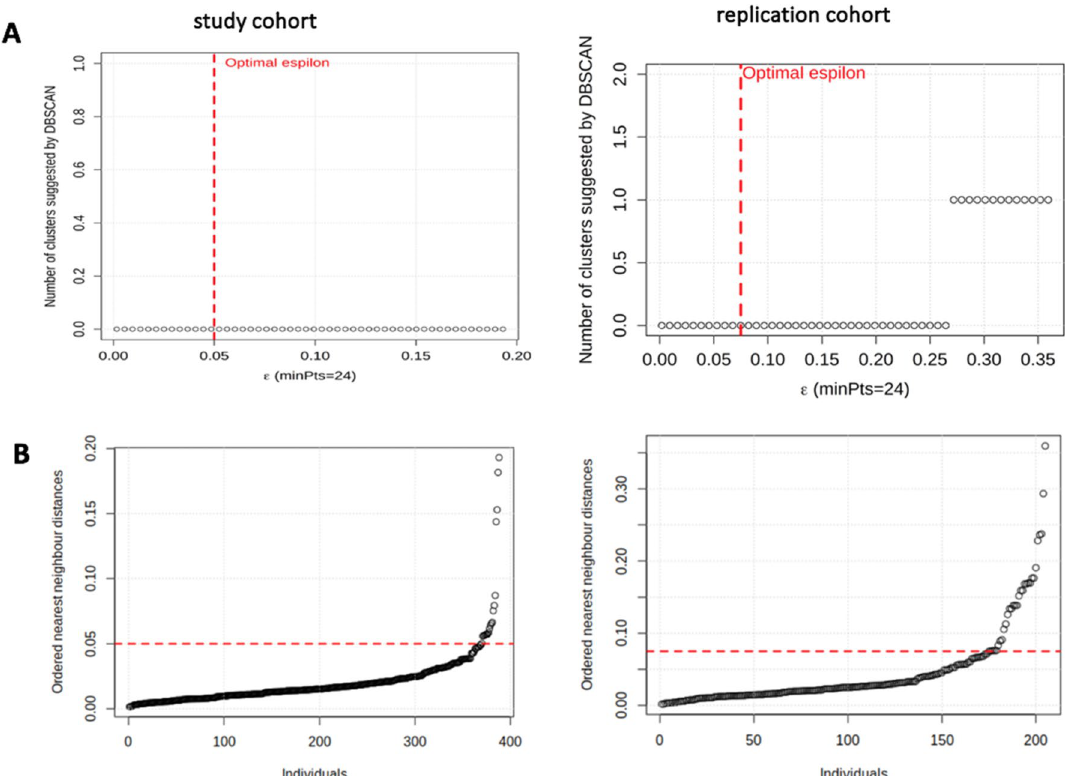
Figure 3. DBSCAN clustering approach. ( A ) Graphs suggested that the data objects were noisy points for the two cohorts, since the obtained number of clusters at the optimal value of ε is zero. ( B ) Graphs show that individuals tend to be closely aggregated together. Graphs were performed using R Software version 3.6.1